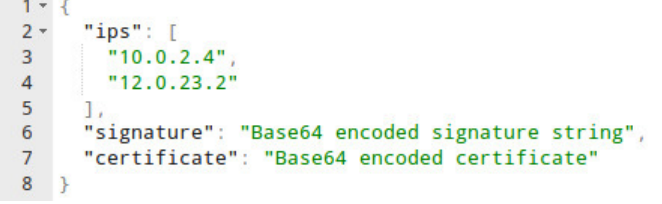
Figure 3. Payload of C-to-C protocol with attack